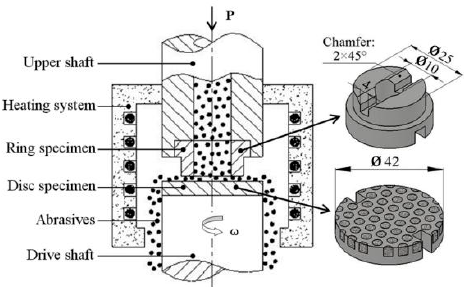
Figure 2. Schematic diagram of the abrasion test rig and the specimens (Dimensions are in mm).